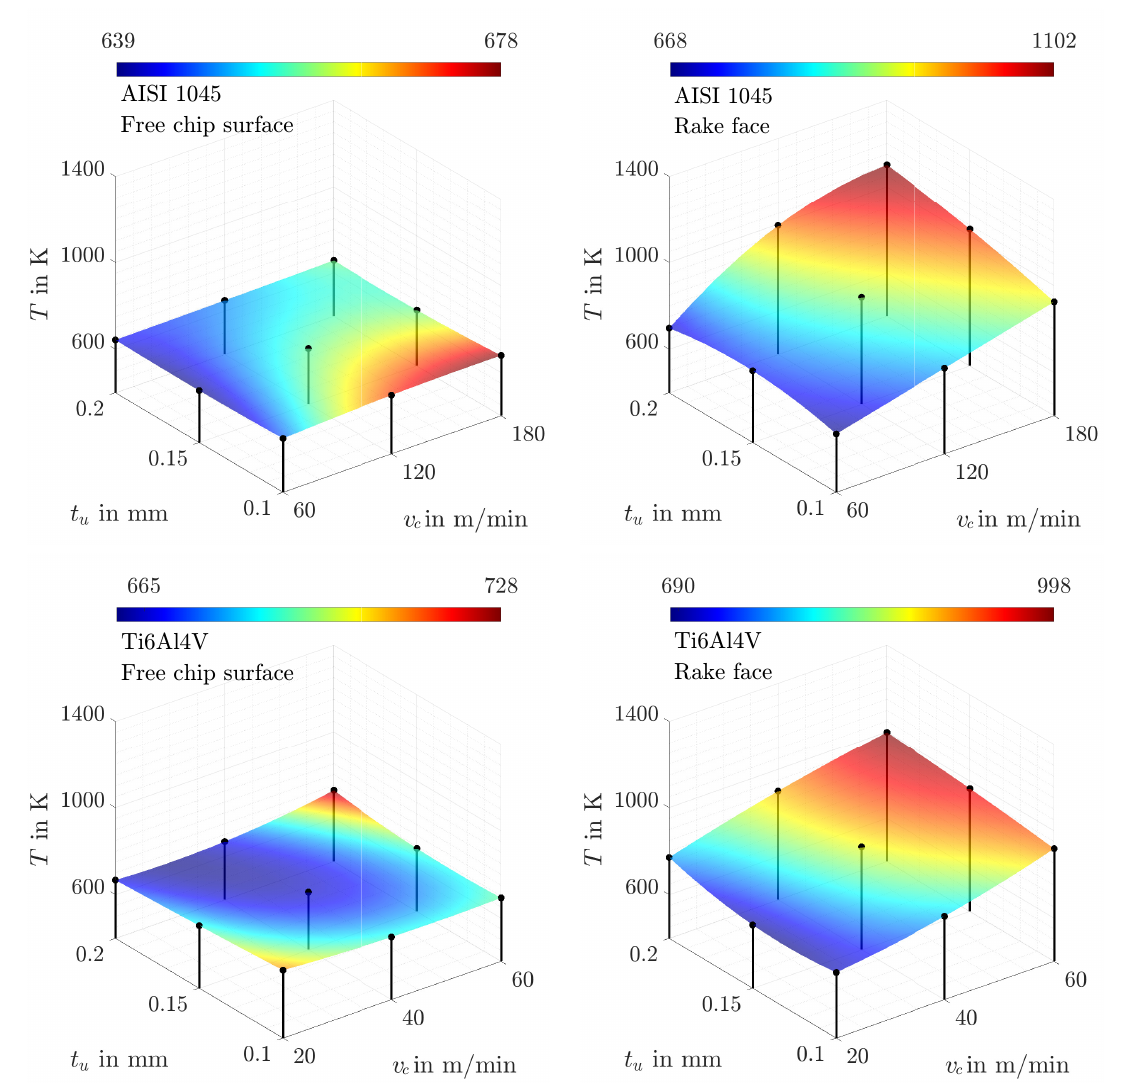
Figure 7. Experimentally measured temperatures plotted as a function of v c and t u . For thermal modeling in the SPH code, the tool and workpiece were treated as a single body but using particles with different thermal conductivity coefficients. The thermal contact are thus naturally handled via the SPH particle-particle interaction. To find the boundary particles for imposing the thermal boundary condition, the enhanced scheme of [40] was employed. This newly proposed thermal modeling approach incorporates a free-surface detection algorithm to identify the interface particles. As a result, the SPH model can resolve the Neumann boundary condition with a negligible computational overhead. Figure 8 shows the temperature distribution at a 2 mm cutting distance, where the high-resolution results are obtained from the CUDA-accelerated simulations. The diameter of the SPH particles in the initial configuration of these two models was 3 µ m. For Ti6Al4V, the temperature in the chip formation zone is too high because the time for thermal conduction is too short and the heat is not diffused sufficiently. This situation leads to a nearly adiabatic process - a common assumption in most Ti6Al4V cutting simulations. For AISI 1045, on the other hand, the thermal diffusivity, α = k / ( ρ c p ) , is five times higher than Ti6Al4V (see in Table 8) and thermal conduction is considerably more pronounced. Comparing the temperature distribution between the AISI 1045 and Ti6Al4V chips clarifies this behavior, vividly seen in Figure